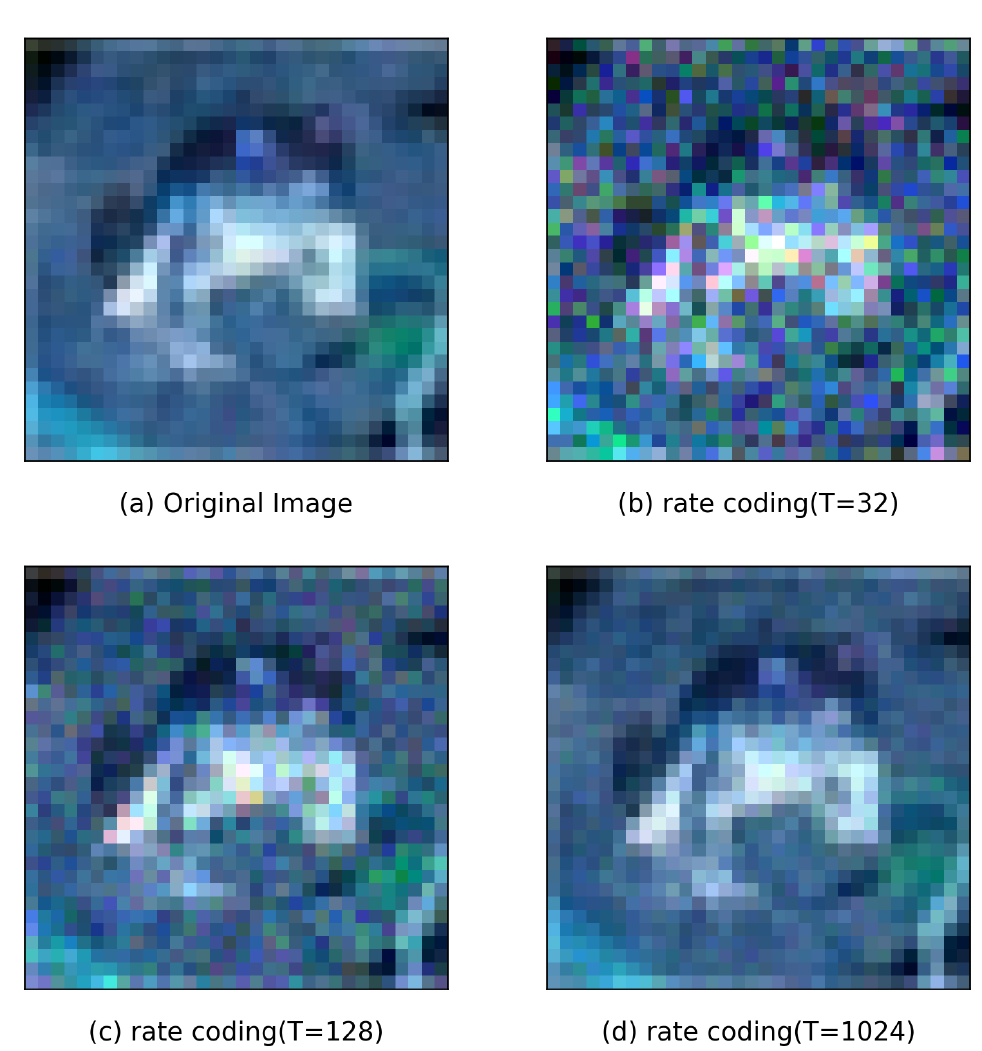
Figure 3. Differences between encoded pictures at different time